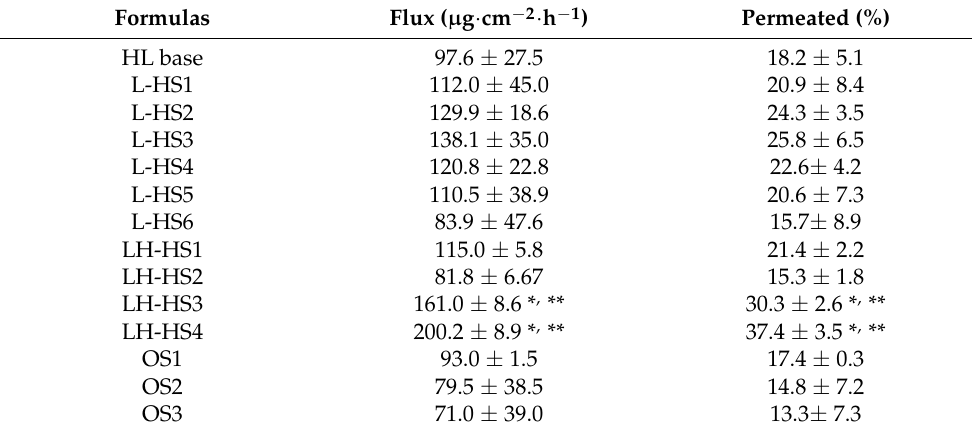
Table 4. Flux and accumulated amount of efinaconazole (EFN) permeated through the bovine hoof for 20 h after the topical application of hydroalcoholic solutions (HSs) or oil solutions (OSs) in Franz diffusion cell